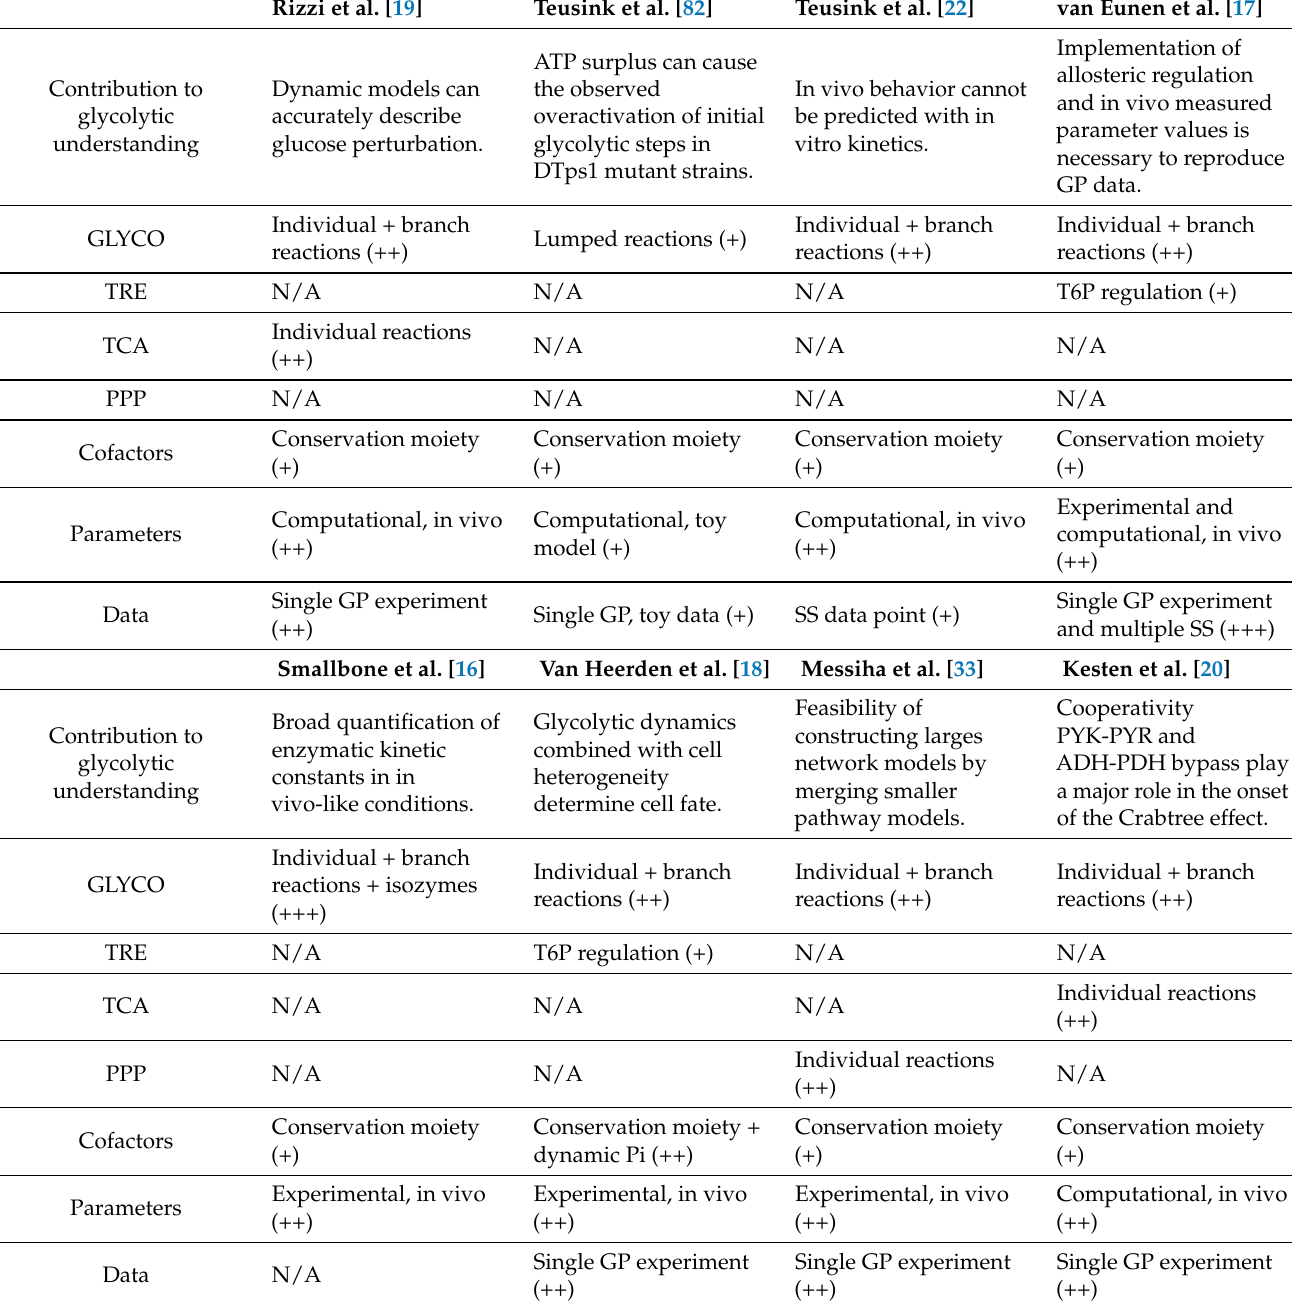
Table 1. Properties of S. cerevisiae models developed to understand dynamic glucose perturbation response: glycolysis (GLYCO), tricarboxylic acid cycle (TCA), pentose phosphate pathway (PPP), trehalose cycle (TRE). Number of ‘+’ sign according to how advantageous the property is. Cofactor conservation moieties are sumAXP and sumNADX. N/A when reactions were not modeled, or data were not shown in article. Refs. [17,20] fitted different parameter sets to multiple data sets. Other models used a unique parameter set. From the literature pool of articles obtained in the systematic reviewing process, only the works which include glycolysis are